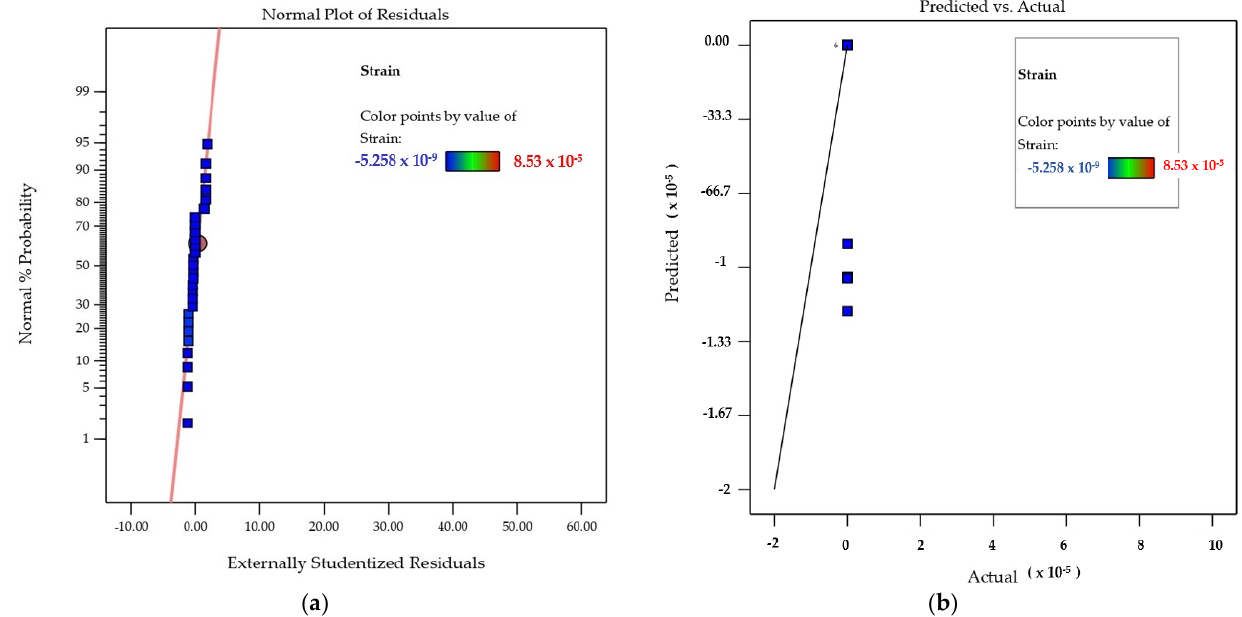
Figure 15. ( a ) Normal plot of residuals for the response strain. ( b ) Actual and predicted values for the response strain ( 𝜀 ).